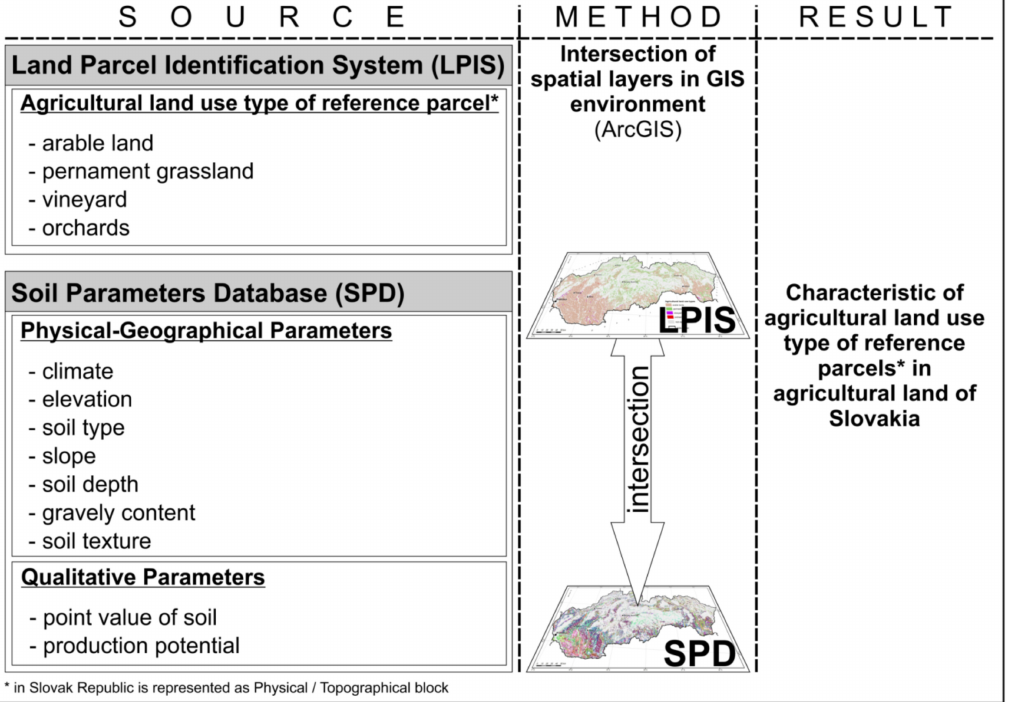
Figure 3. Scheme of